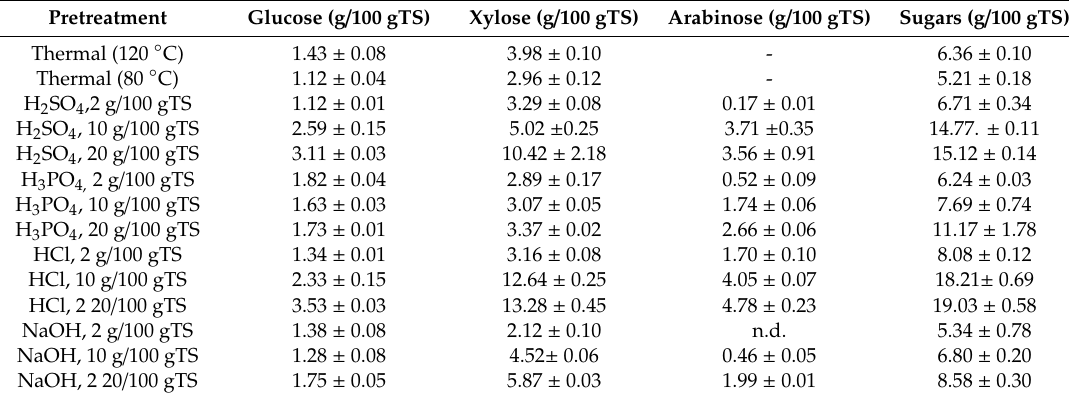
Table 1. Concentration of glucose, xylose, arabinose and sugars accompanied by their standard deviations, contained in the liquid fractions obtained after di ff erent pretreatment methods.